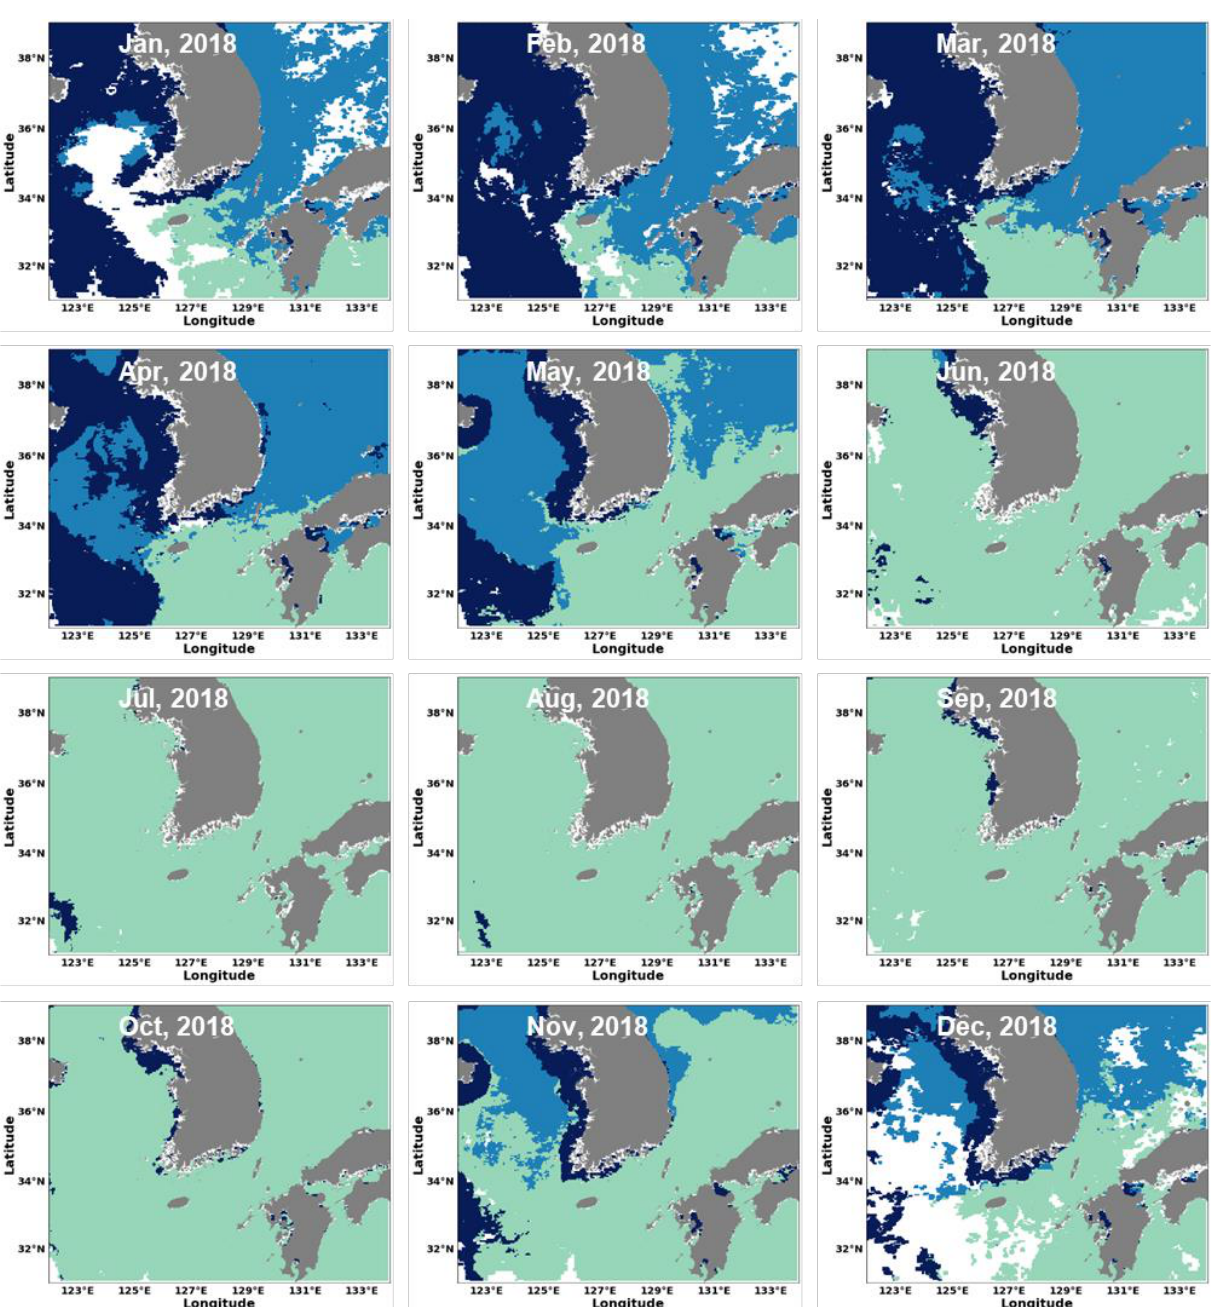
Figure 3. Classification based monthly PSCs distribution using L3 mapped VIIRS data in 2018. White color indicates missing area by cloud. Indigo, blue, and green colors indicate micro-size phytoplankton, nano-size phytoplankton, and pico-size phytoplankton, respectively.